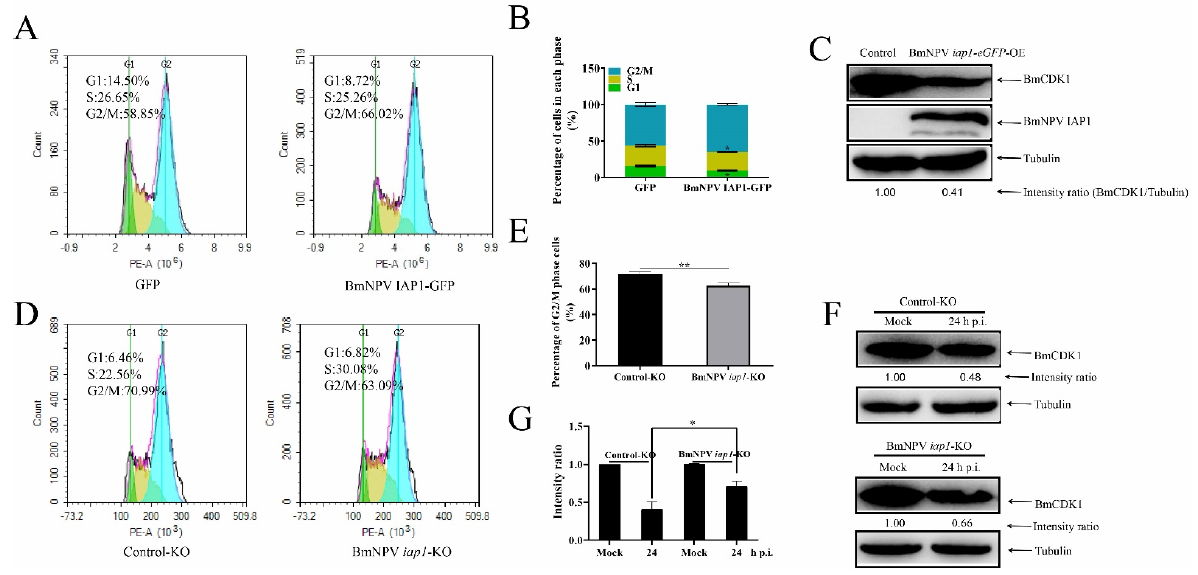
Figure 5. BmNPV iap1 regulates the cell cycle via BmCDK1 . ( A , B ) Comparison of cell cycle distribution in pIZ- eGFP and pIZ-BmNPV iap1 - eGFP groups. The pIZ- eGFP group was used as a negative control. The data were analyzed as mean ± SD from three independent experiments. ( C ) The amount of BmCDK1 was analyzed after co-transfecting with pIZ- BmCDK1 -Flag, pIZ-BmNPV iap1 -HA, pIZ- BmCDK1 -Flag, and pIZ-V5/His, successively. Tubulin was adopted as the loading control. ( D , E ) 48 h post transfection with control-KO and BmNPV iap1 -KO, cells were infected with BmNPV. The percentage of G2/M phase cells 24 h p.i. were presented as mean ± SD from three independent experiments. ( F ) The amount of BmCDK1 protein were detected in no-infected and 24 h p.i. cells using Western blotting. Tubulin was adopted as the loading control. The protein band density ratios of BmCDK1 were calculated by protein band density analysis using Image Lab. ( G ) Results shown with graphs representing the intensity of the BmCDK1/tubulin ratio. Statistical differences were analyzed with Student’s t -test (* p < 0.05 and ** p <